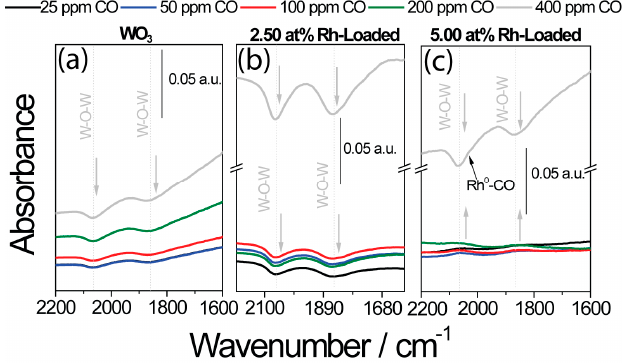
Figure 8. DRIFT spectra taken during exposure to different CO concentrations in low-oxygen (50 ppm O 2 ) backgrounds for ( a ) unloaded WO 3 sample, ( b ) 2.50 at.% Rh 2 O 3 loaded WO 3 , and ( c ) 5 at.% Rh 2 O 3 loaded WO 3 .